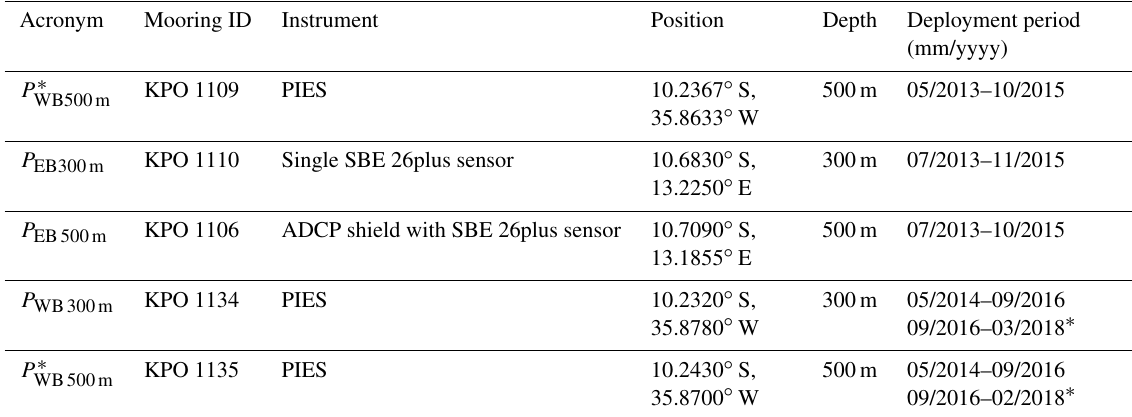
Table 1. Collection of available BP measurements at 11 ◦ S. Acronyms used throughout this article are given in the first column; official mooring IDs and instrument types are listed in the second and third columns. Columns 4–6 give the positions, depths and deployment periods for each BP measurement. The BP data can be found at https://doi.org/10.1594/PANGAEA.907589.